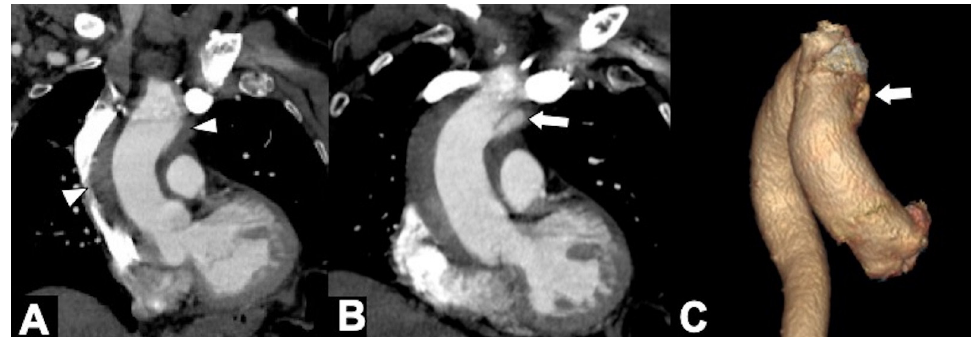
Figure 9. Unstable Type A IMH complicated by ulcer-like projection (ULP). ( A ) Coronal oblique CTA shows type A IMH (arrowheads) in a 68-year-old man with hypertension and chest pain. The total aortic diameter was less than 50 mm and the IMH thickness less than 11 mm; he underwent medical management initially. ( B ) Three-day follow-up coronal oblique CTA image shows disease progression by an ULP due to opening of intimal tear (arrow). ( C ) 3D-volume-rendered (VR) reconstruction confirms ULP (arrow).